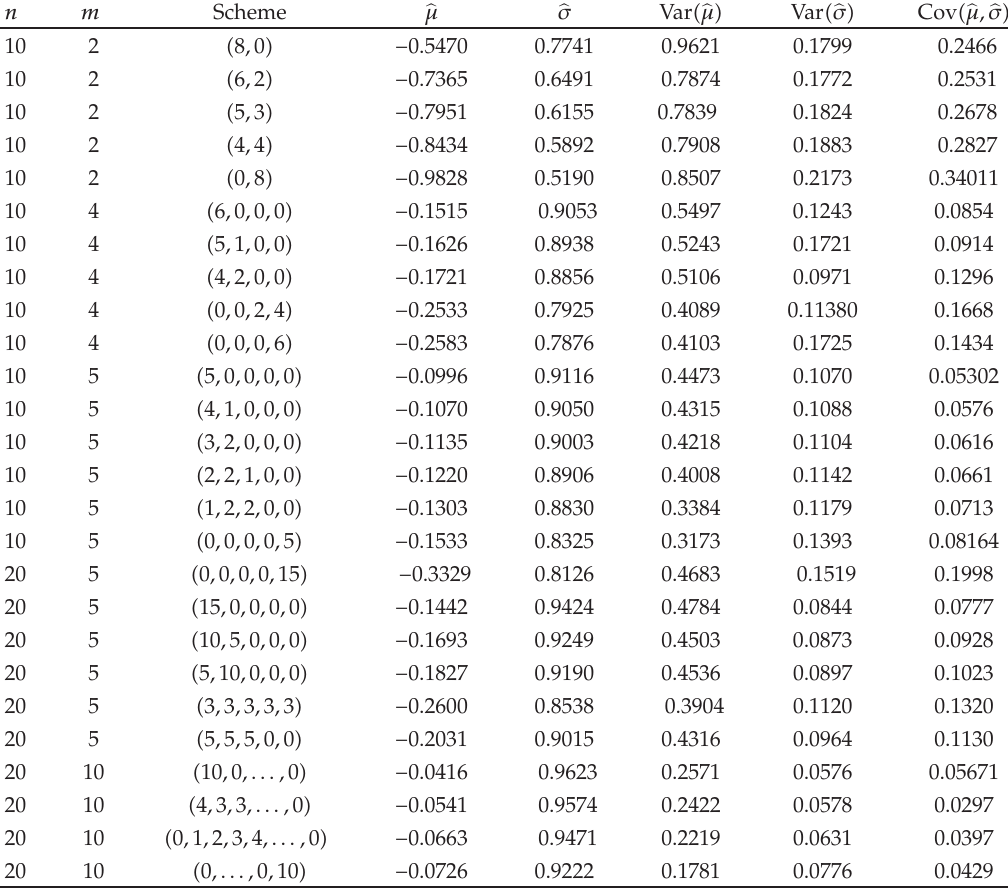
Table 2: Average, variances, and covariance of the MLEs when the shape parameter φ (cid:7)